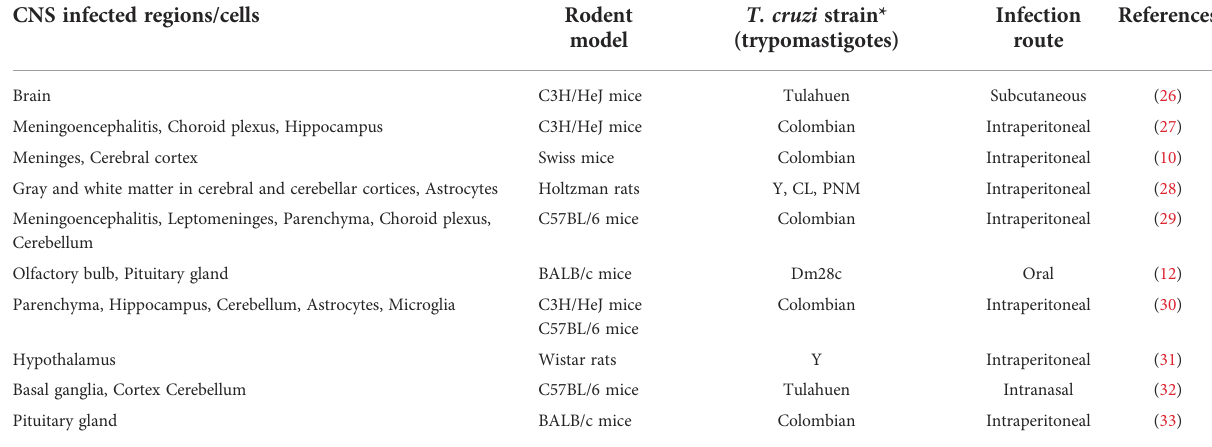
TABLE 1 Experimental T. cruzi infection models with CNS